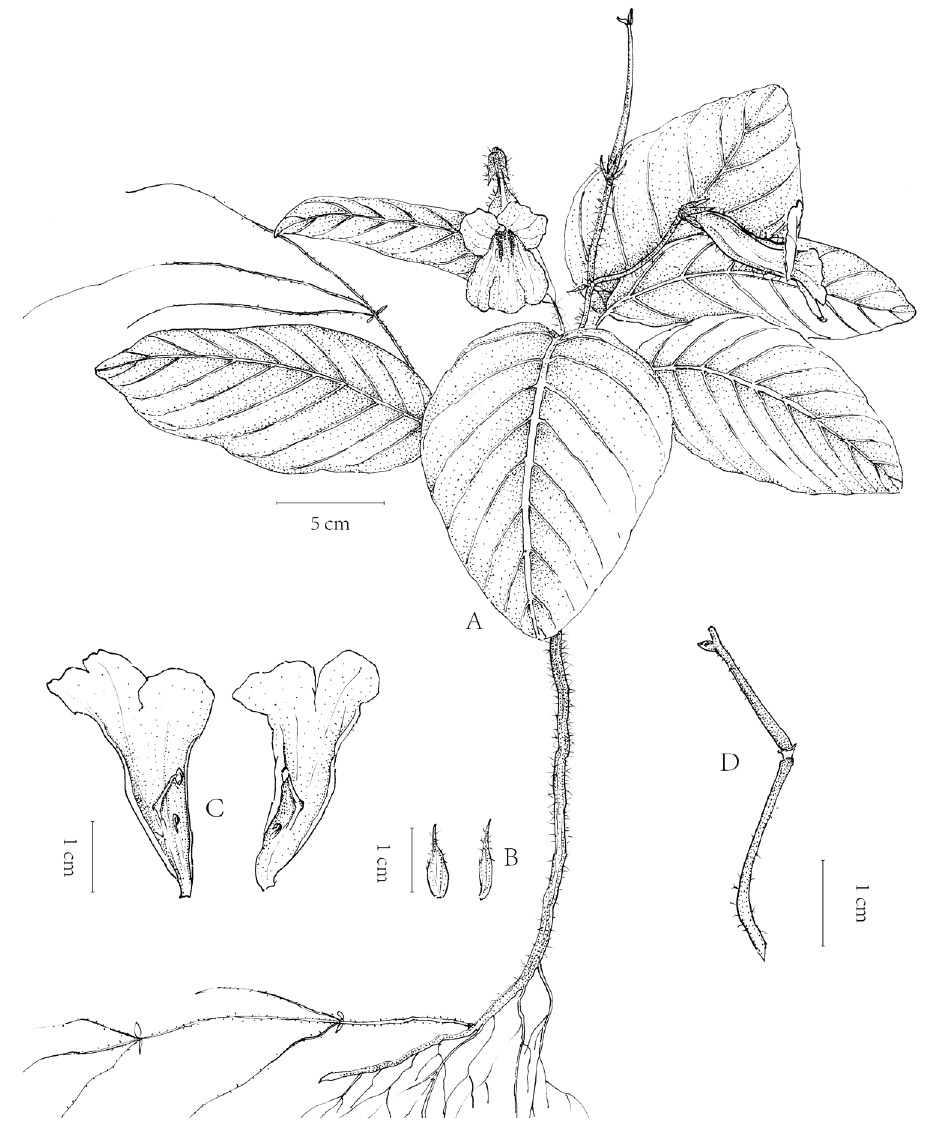
Figure 8. Henckelia xinpingensis Y.H.Tan & Bin Yang, sp. nov. A Habit B calyx lobes C corolla (Dis- sected) D pedicel with pistil. Drawn by Zheng-meng